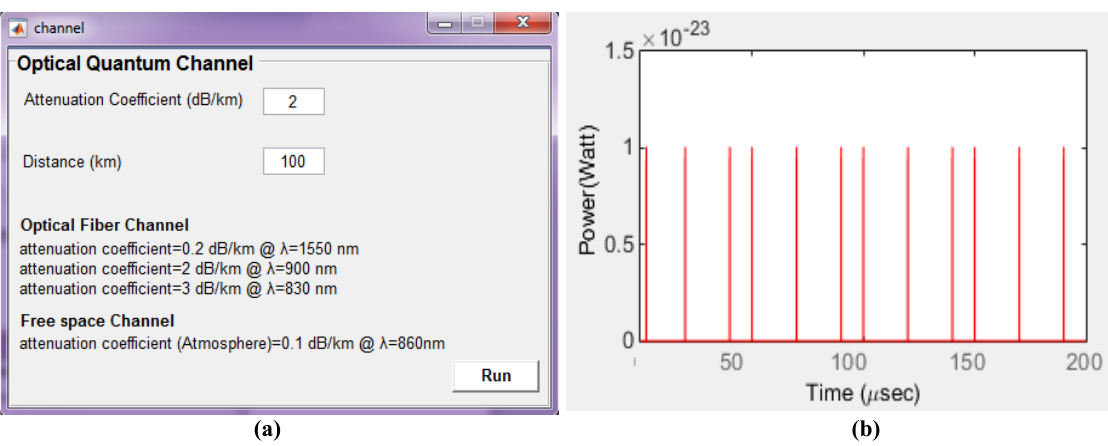
Fig. 7. Test 2 (a) GUI set up (b) result for OF quantum channel for L=100km and α_p=2 dB/km.